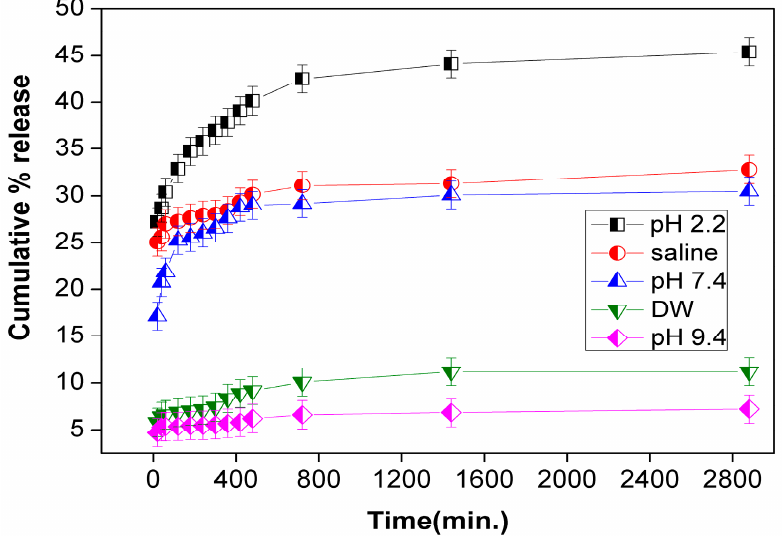
Figure 5. Cumulative % ondansetron release by SDS/FeSP nanocomposite.